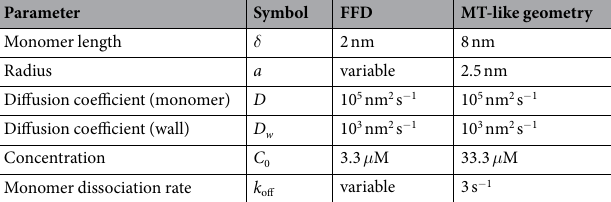
Table 1. Numerical values of the various parameters used in the Brownian dynamics simulation for flat-faced filaments (FFD) and microtubule-like geometry.